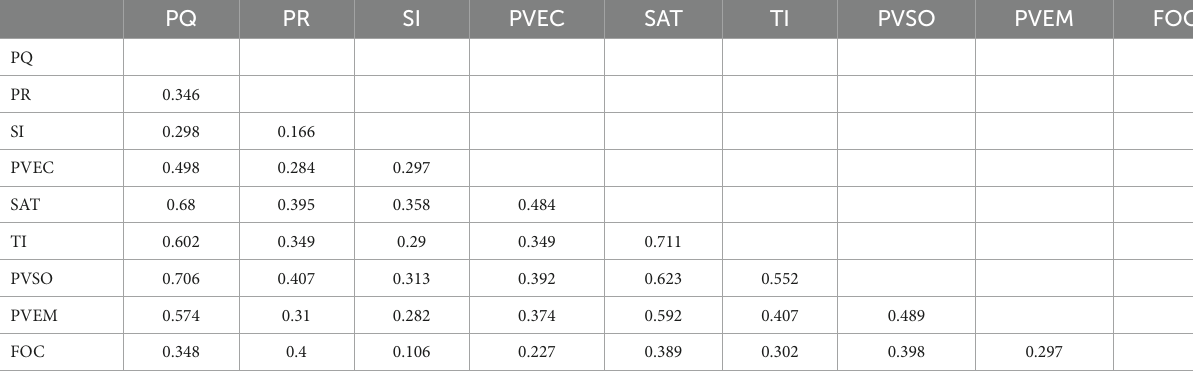
TABLE 3 Discriminant validity (HTMT criteria).